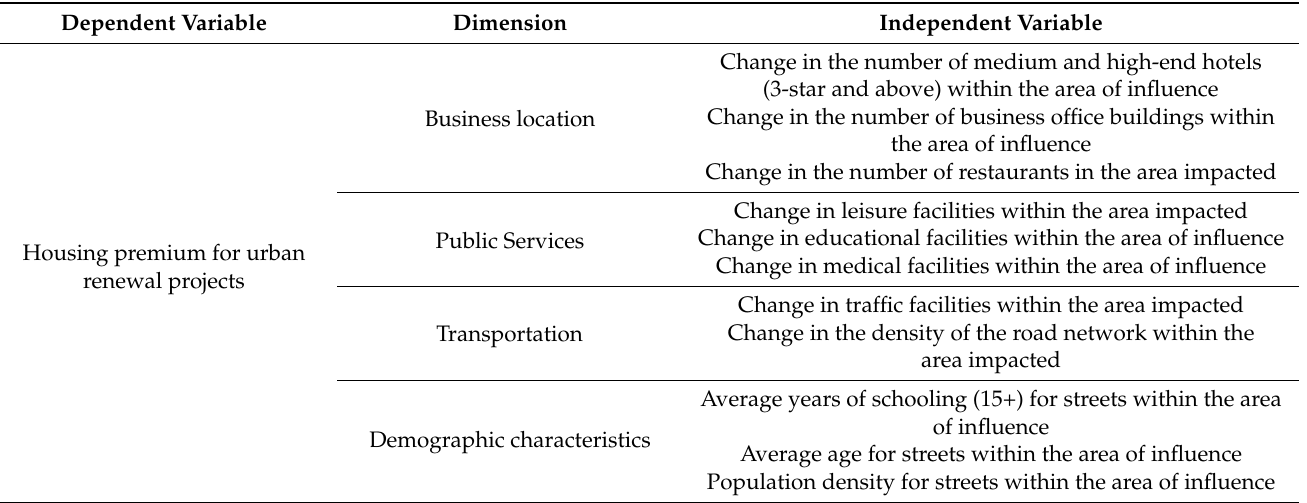
Table 4. Index system for the impact of urban renewal on the housing